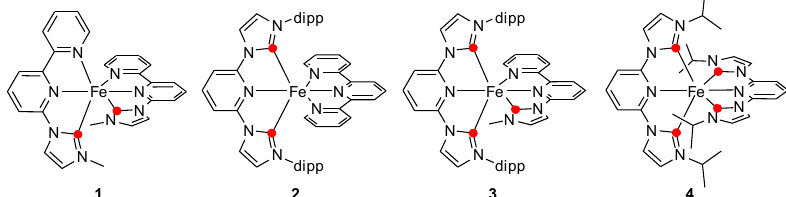
Fig. 1. Investigated complexes (with dipp = diisopropylphenyl). The NHC functions are indicated by red